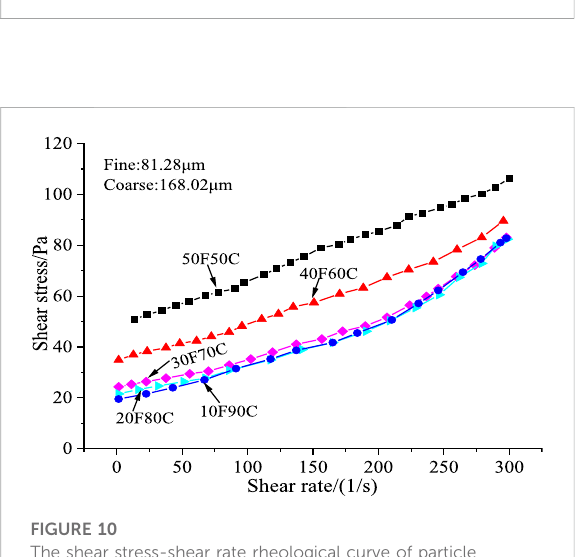
FIGURE 9 The shear stress-shear rate rheological curve of particle diameter 55.53 μ m.